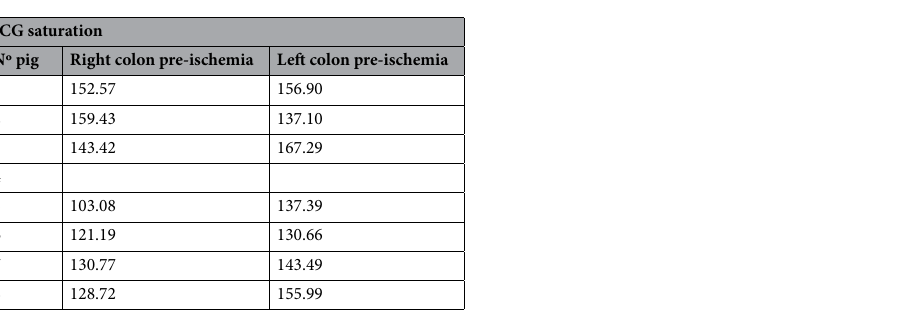
Table 1. Summary of the mean saturations in the right colon and left colon during the control period, prior to the section of the inferior mesenteric artery and vein.